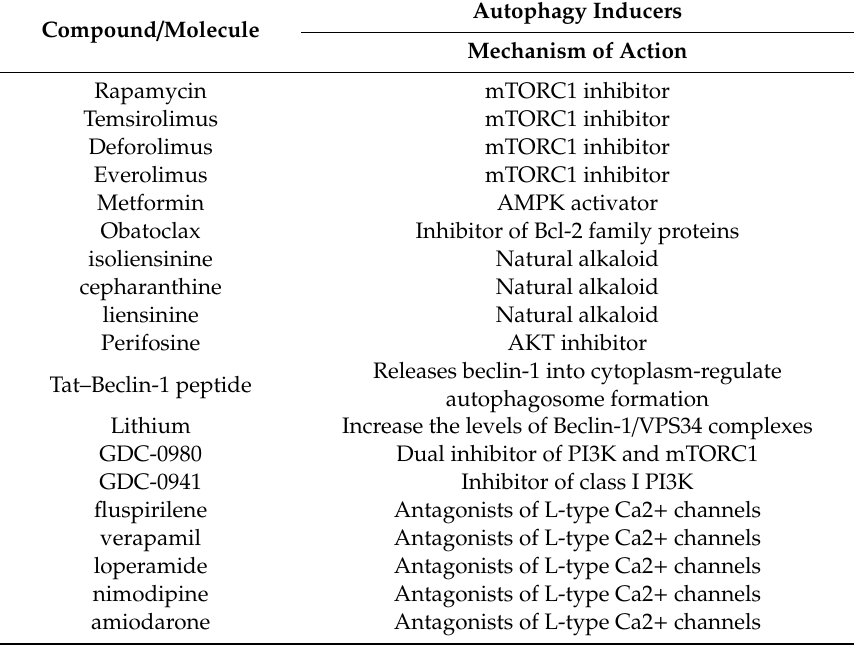
Table 3. Commonly used molecules to induce autophagy. Small molecules that have been identified as autophagy inducers and the primary mechanism of